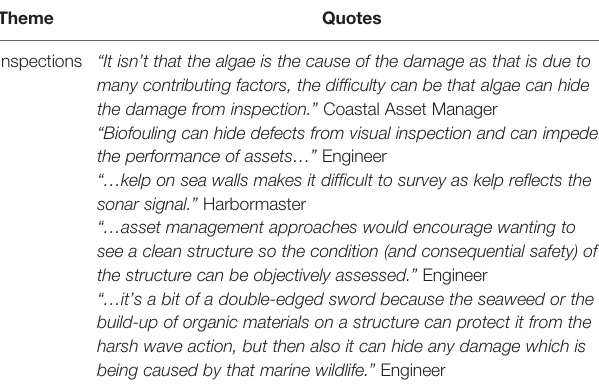
TABLE 6 | Illustrative quotes concerning the perceived impacts of marine growth on maintenance